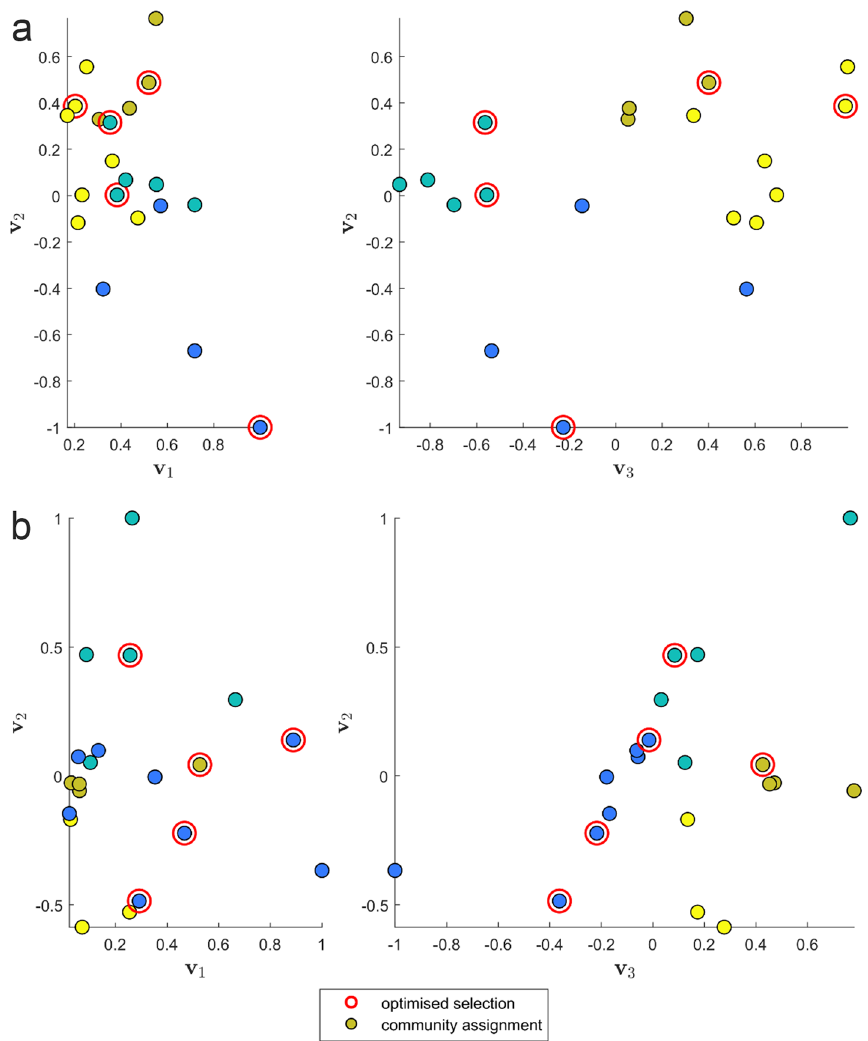
Fig. 2 Nodes embedded in a Euclidean space according to the dominant eigenvectors of the ground station relationship network ( Ŵ ). Node colour denotes community assignment according to CDI, see Clark et al. (2019). The plots in a represent the global target scenario with the n pass = 4 selection from Fig. 1a displayed. The plots in b represent the Caribbean scenario with the n pass = 7 selection from Fig. 1c